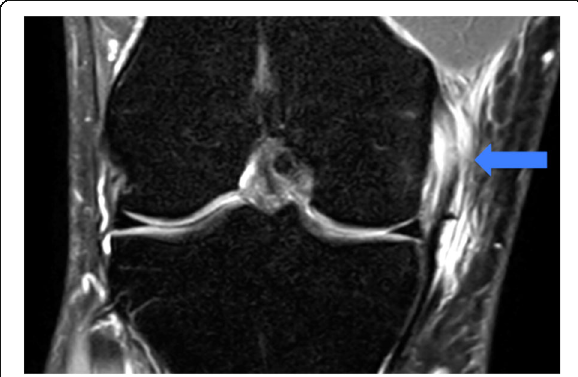
Fig. 3 Knee Medial Collateral Ligament tear proximal, MRI T2 image with a proximal hypersignal of the MCL representing by the blue